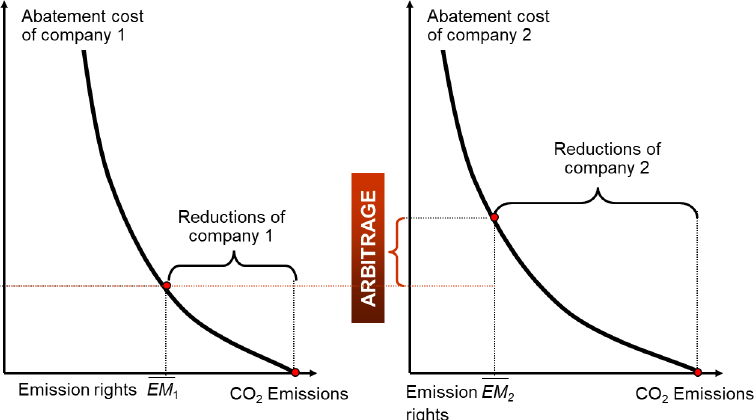
Fig. 3. – Benefit of emission